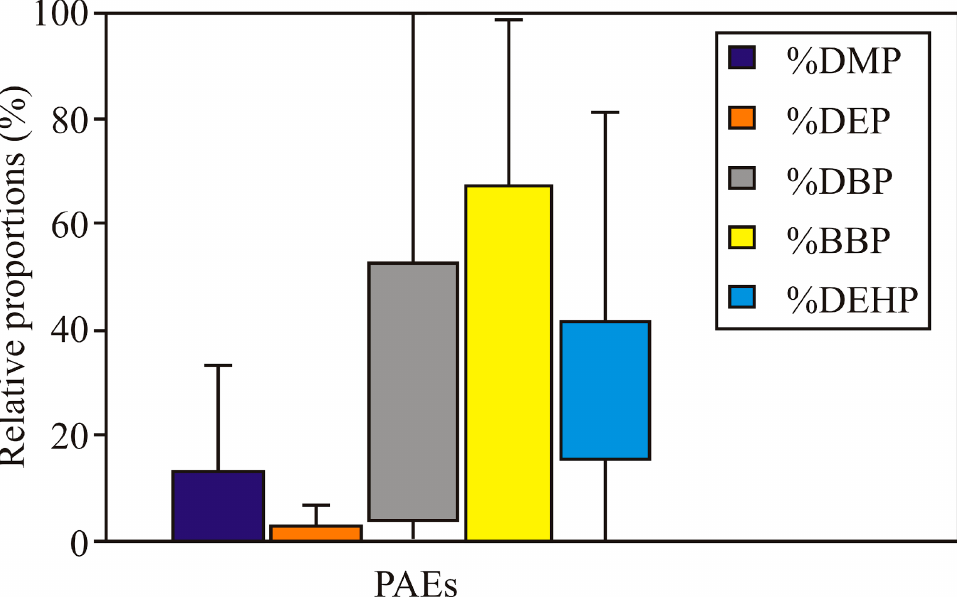
Figure 4. The relative proportions of the five PAEs (DMP, DEP, DBP, BBP, and DEHP) in the soils collected from 164 sites. collected from 164